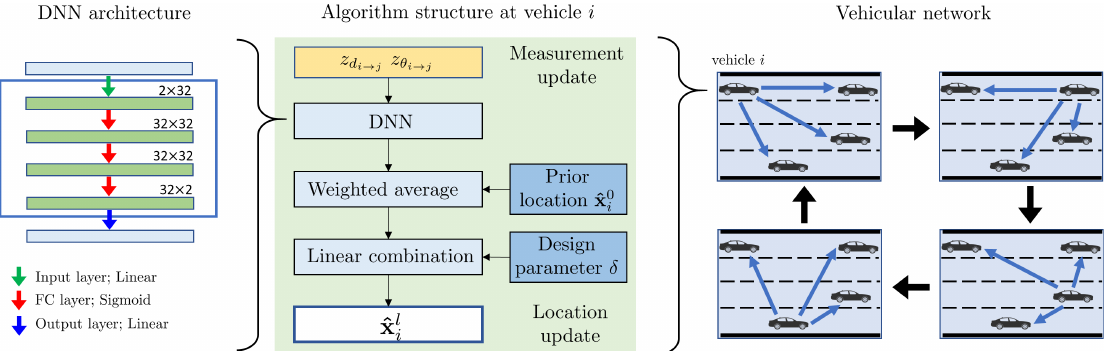
Figure 2. Deep neural network (DNN)-assisted cooperative and distributed localization algorithm scheme.